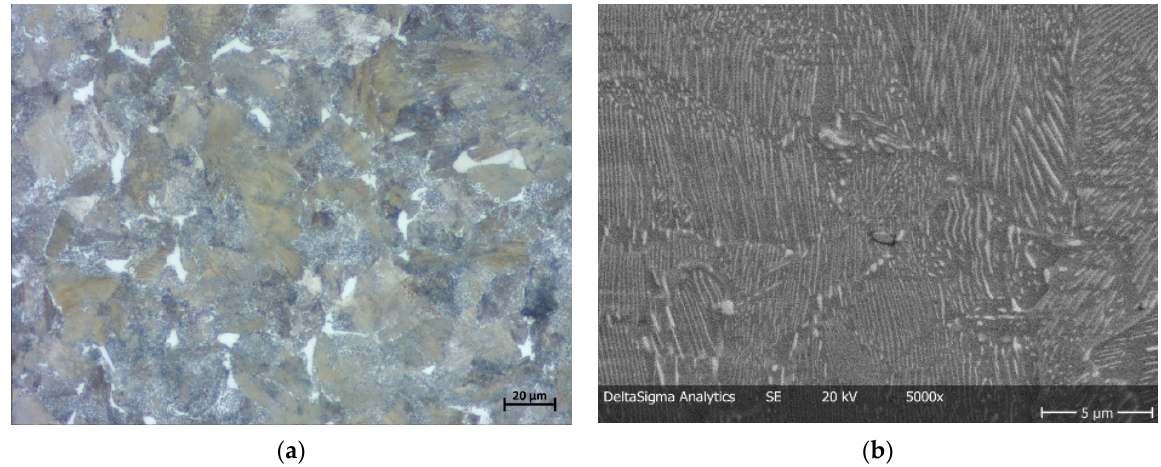
Figure 1. Micrographs of the initial material showing primary pearlitic microstructure (needles) with a few ferritic areas (bright spots): ( a) optical microscopy and with increased magnification in ( b ) SEM micrograph of the same condition.